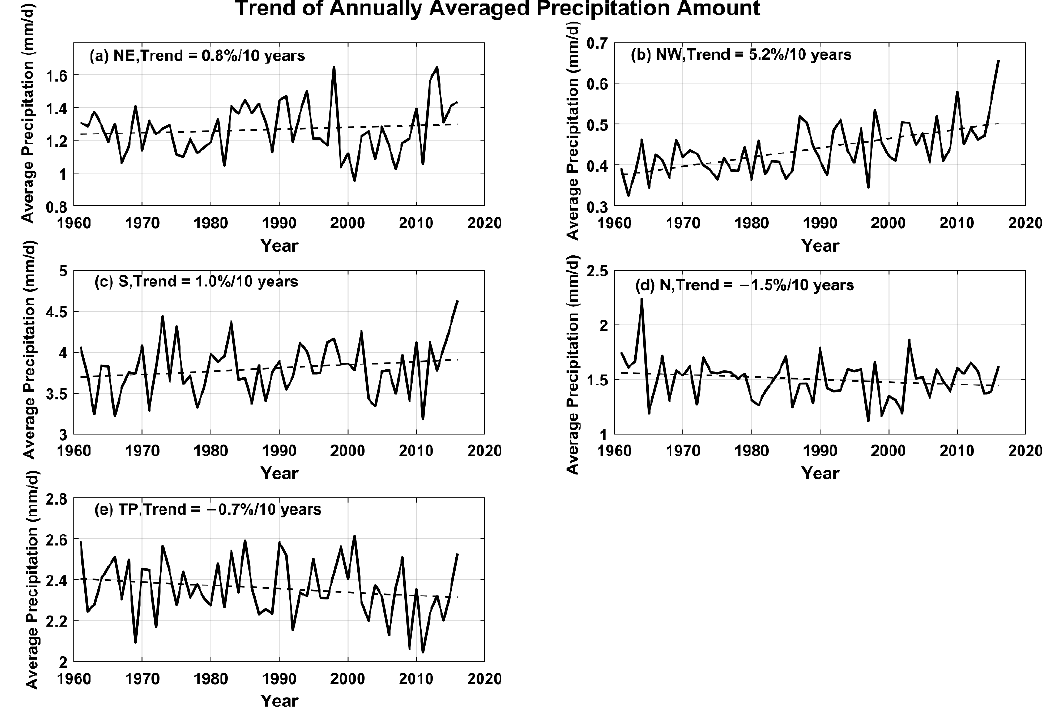
Figure 3. The temporal trend of annually averaged precipitation amount for the whole area over the 5 classified regions of ( a ) Northeast China (NE), ( b ) Northwest China (NW), ( c ) South China (S), ( d ) North China (N), and ( e ) Tibetan Plateau (TP). The dashed line represents the linear temporal trend. Unit mm/d demotes millimeter per day.